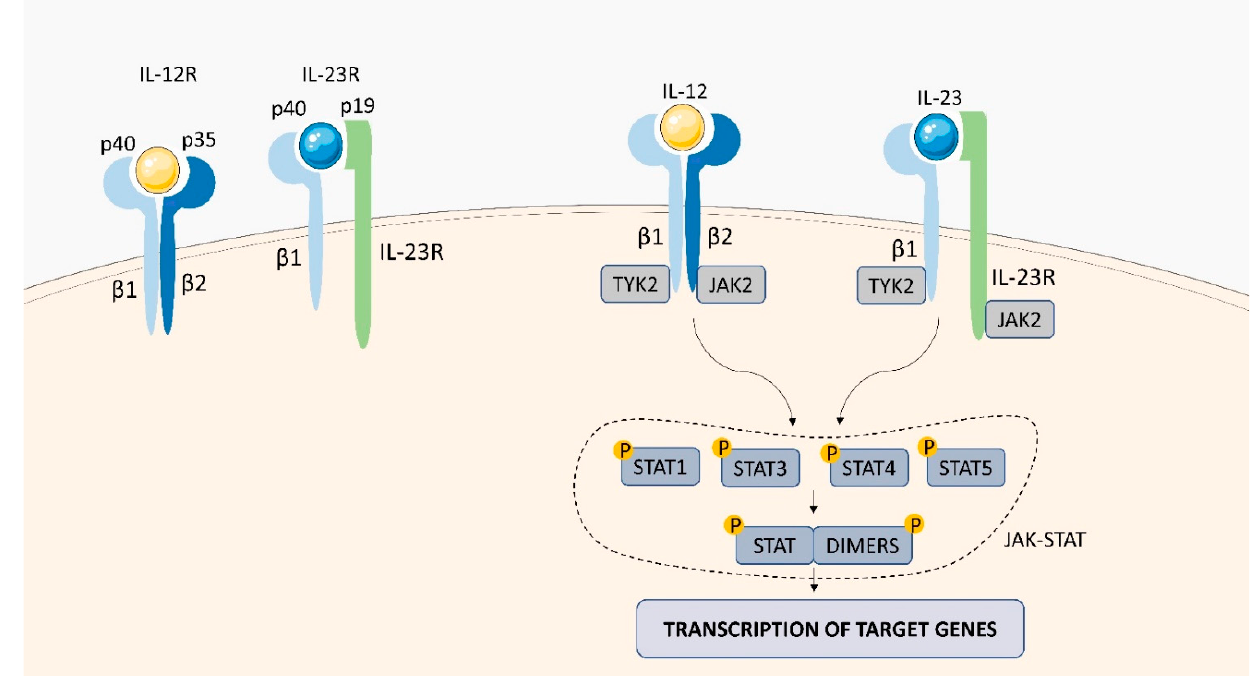
Figure 6. IL-12R and IL-23R structures and signaling. The IL-12 receptor consists of IL-12/23p40 and IL-12p35 subunits, and IL-23 receptor is formed by IL-23p19 and IL-12/23p40 subunits. The interaction of IL-12/23 with IL-12R/23R activates the tyrosine kinases JAK2 /TYK2. The JAK-STAT pathway is activated, which stimulates the transcription of genes in the cell nucleus, leading to the production of cytokines.